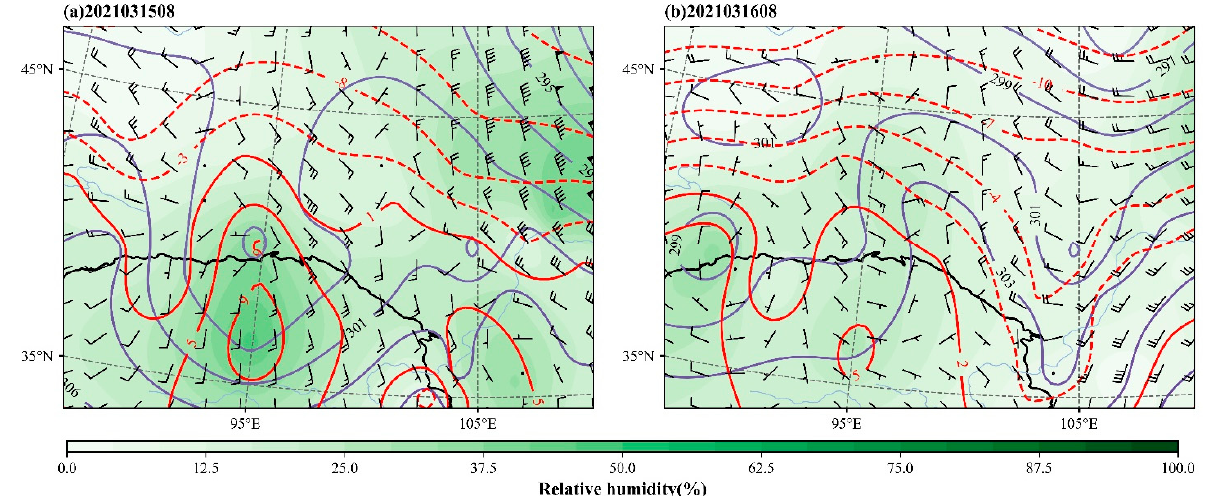
Figure 5. Superposition diagram of geopotential height (purple contours), temperature (red isotherms), wind field, and relative humidity at 700 hPa. ( a ) 08:00, 15 March 2021; ( b ) 08:00, 16 March 2021.